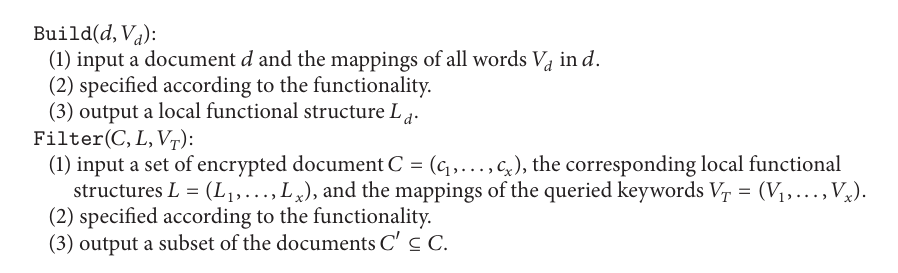
Algorithm 2and the search scheme in Algorithm 3and finally present the complete scheme in Algorithm